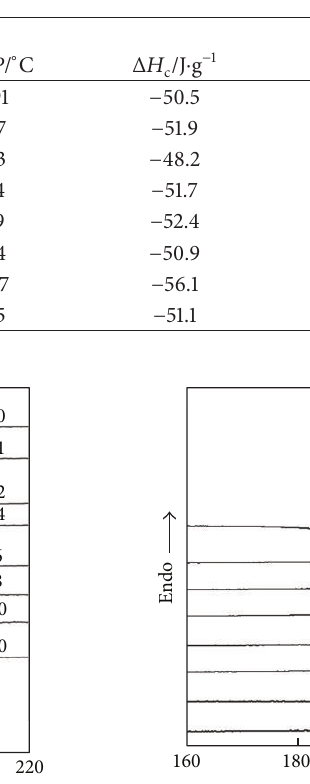
Table 2: DSC parameters of different PTT/CaCO